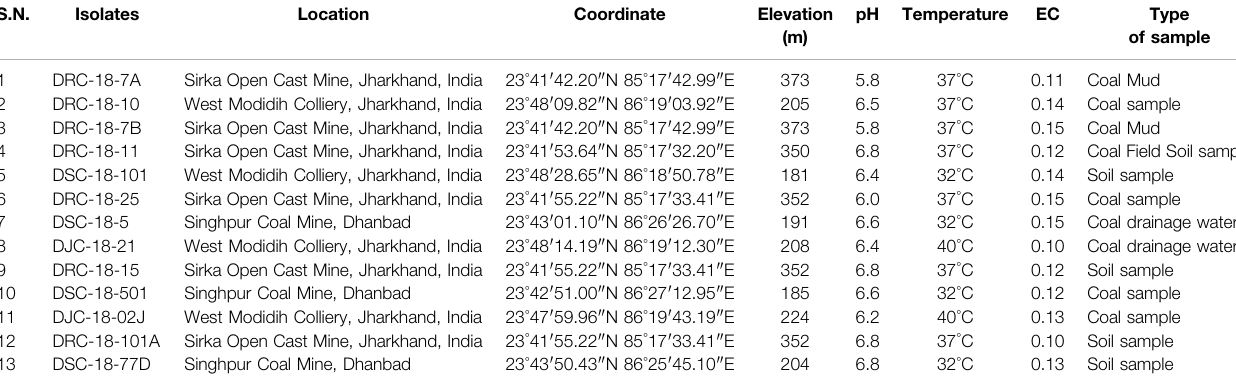
TABLE 1 | Geographical locations of different coal mines in Jharkhand province of India for collection of samples for isolation of sulfur-oxidizing bacteria.